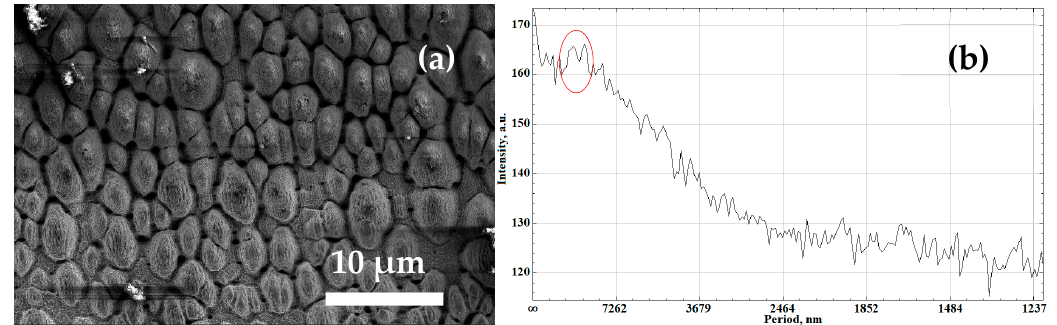
Figure 9. Image analysis for conical microstructures for 21 J/cm 2 with five scan repetitions: ( a ) SEM image with conical microstructures; ( b ) fourier transform graph with a peak corresponding to the average conical structure size marked in red. Table 6. Average distance between cone tops per